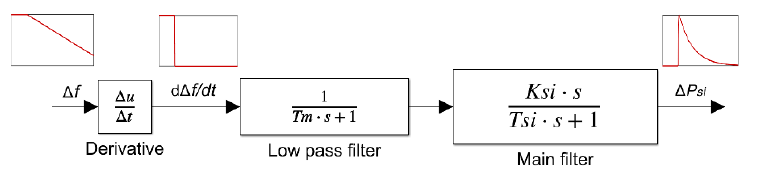
Figure 2. Proposed structure of the synthetic inertia controller and visualization of the idealized control signals (above).